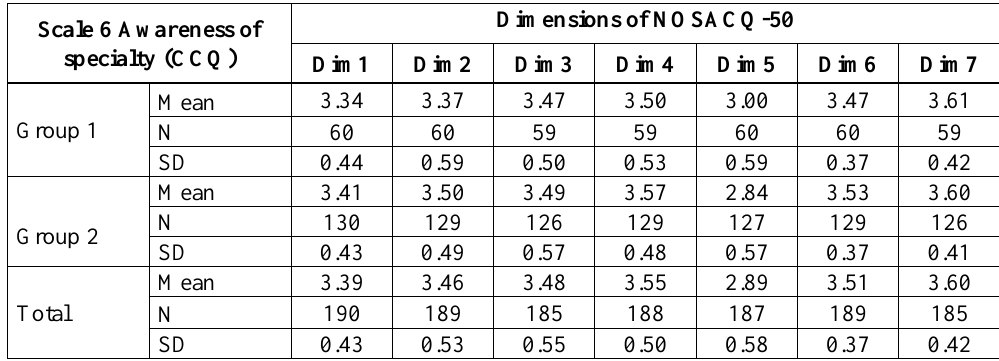
Table 8. Relationships between Factors of Safety Climate and Scale of Professional Competence “Awareness of Specialty” among